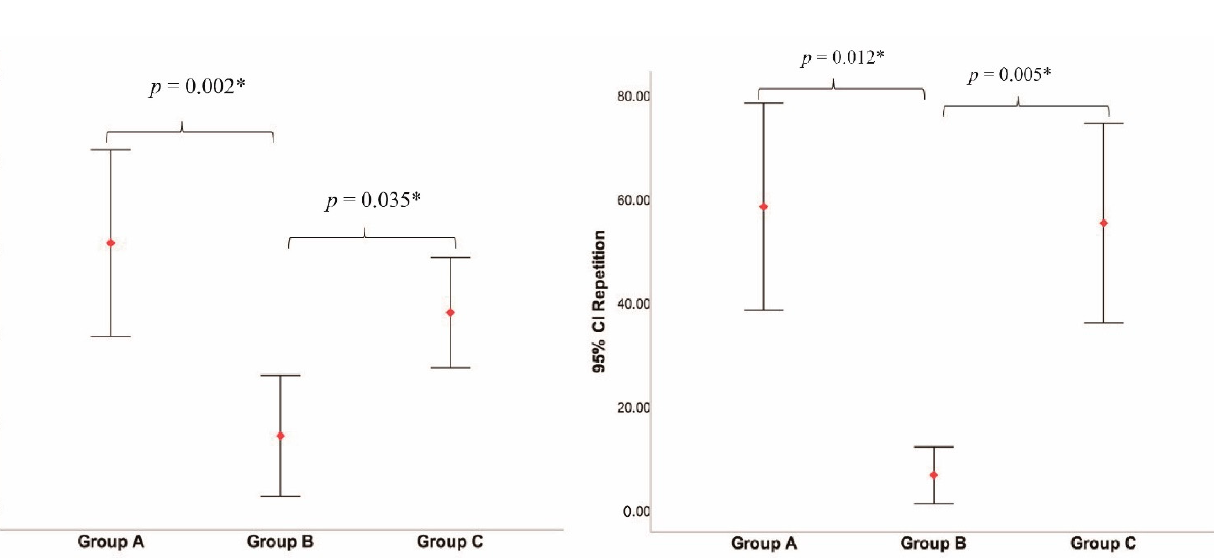
Figure 5. Multiple comparison tests for intergroup differences in language subsets. * Statistical significance level: α = 0.05. 3.6. Intergroup Diffusion Indices Analyses We attempted to reconstruct the segments of bilateral AFs in all patients according to the approach mentioned. As a result, the left AF was completely reconstructed in 8 cases (group A, patient 01–08), non-reconstructed in 6 cases (group B, patient 09–14), and partially reconstructed in 12 cases (group C, patients 15–26). In group C, only the ASAF was non-reconstructed in two cases (patients 15–16), only the PSAF was non-recon- structed in two cases (patient 17–18), and only the LSAF was non-reconstructed in two cases (patient 19–20); however, both the ASAF and LSAF were non-reconstructed in four cases (patient 21–24), and both the PSAF and LSAF were non-reconstructed in two cases (patient 25–26). In total, the ASAF was non-reconstructed in six cases (50%), the PSAF was non-reconstructed in four cases (33%), and the LSAF was non-reconstructed in eight cases (66.7%). In addition, despite being reconstructed, different degrees of damage to the re- sidual portion of the left AF segments were observed in the patients of group C. The re- construction of the AF segments was presented in Figure 2. Because of the non-normal distribution of the DTI parameters in the left AF ( p < 0.05), the independent samples Kruskal–Wallis test was applied to estimate the significance among groups. The results showed significant intergroup differences in both the FA value